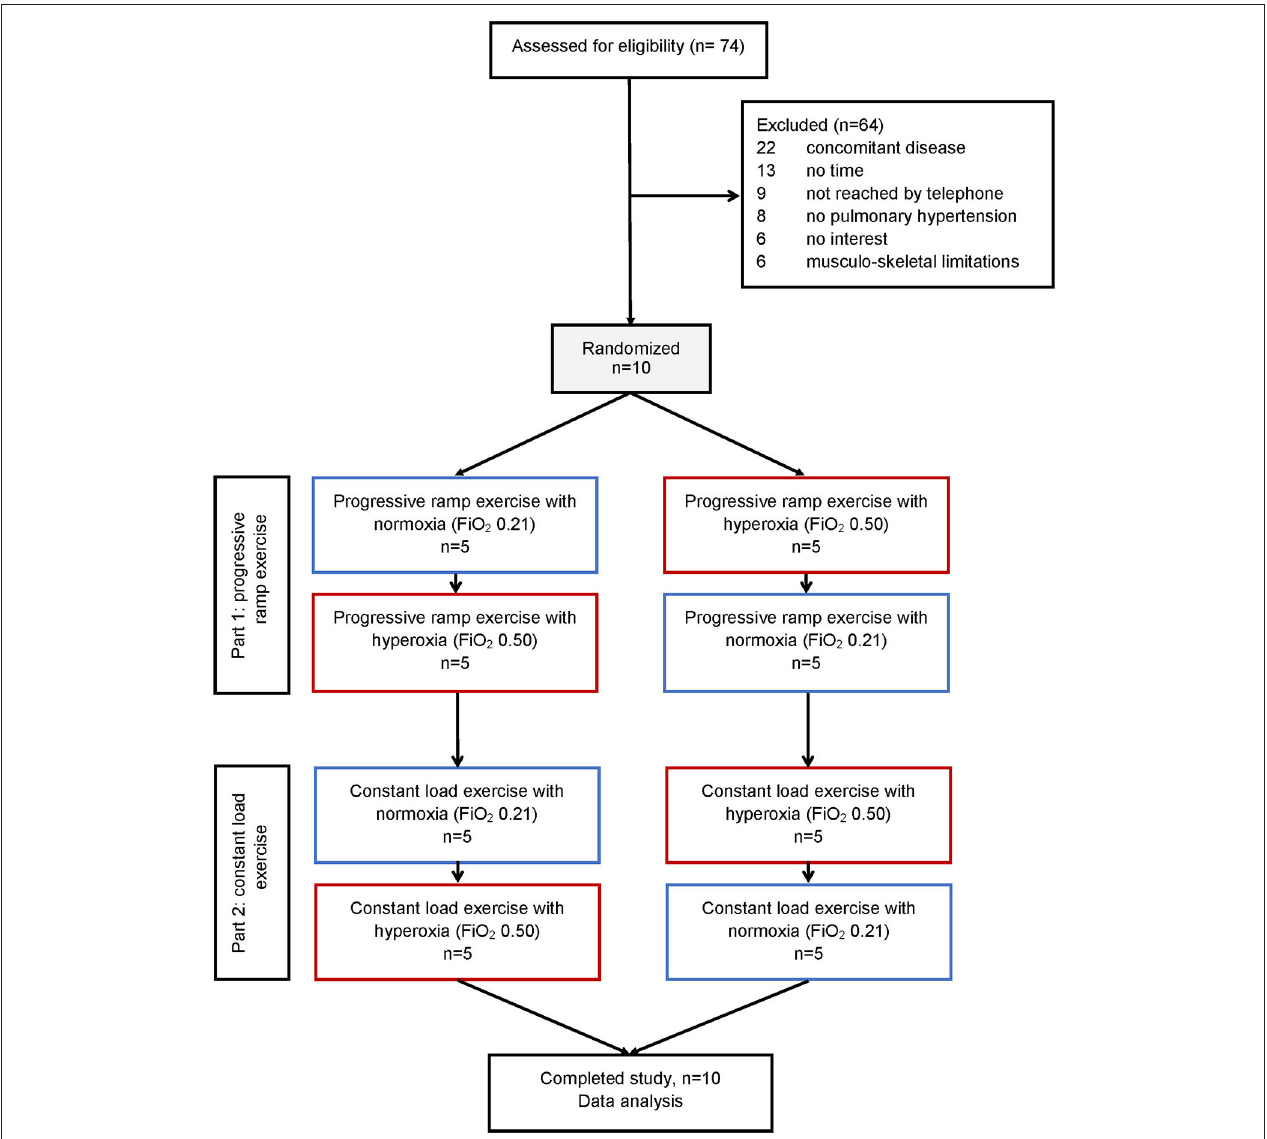
FIGURE 1 | Patient flow of the study. N = Number of